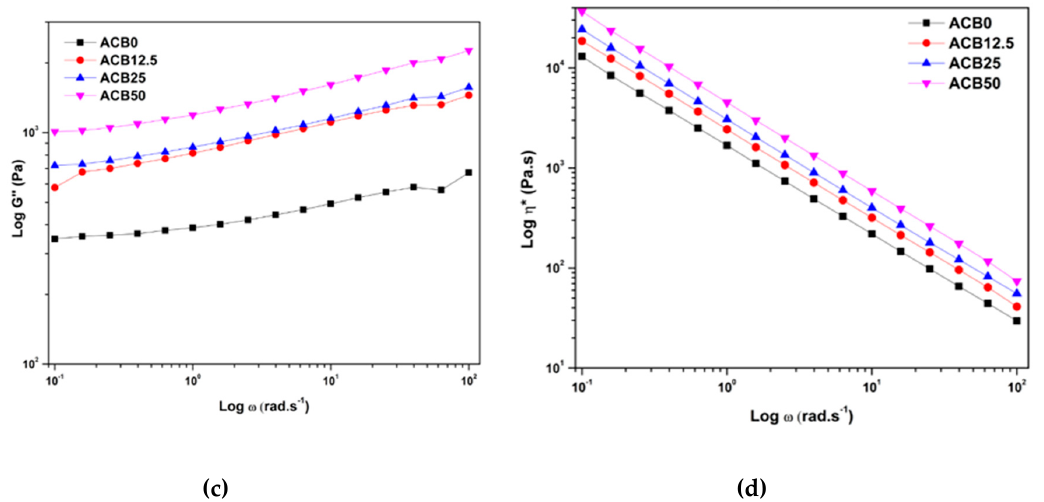
Figure 5. ( a ) Stress–strain profiles (inset: compressive modulus of elasticity), ( b ) storage modulus (G ′ ), ( c ) loss modulus (G ″ ) and ( d ) complex viscosity ( η * ) of swollen ACB hydrogels recorded at 25 °C.